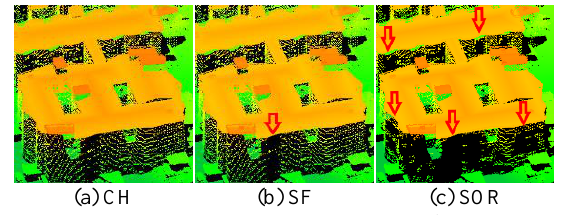
Figure 7. FN occurrences on building walls for the three evaluated filters